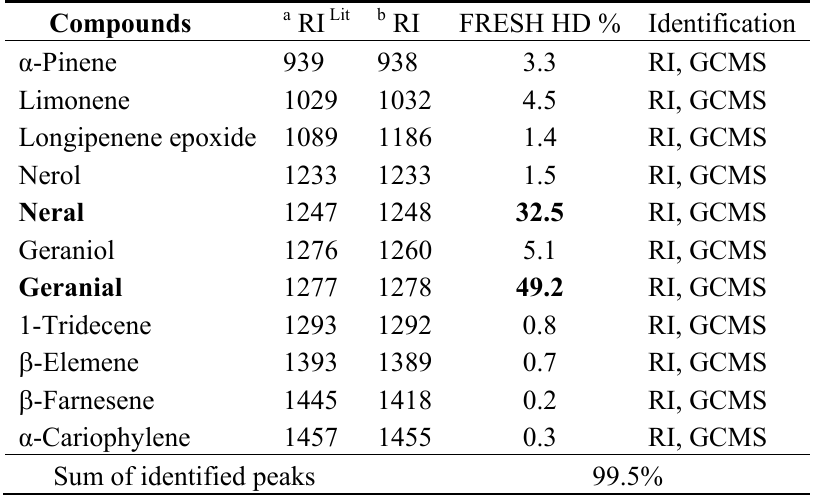
Table 1. Identified Compounds in the aerial parts essential oil of P. brevipedunculata .